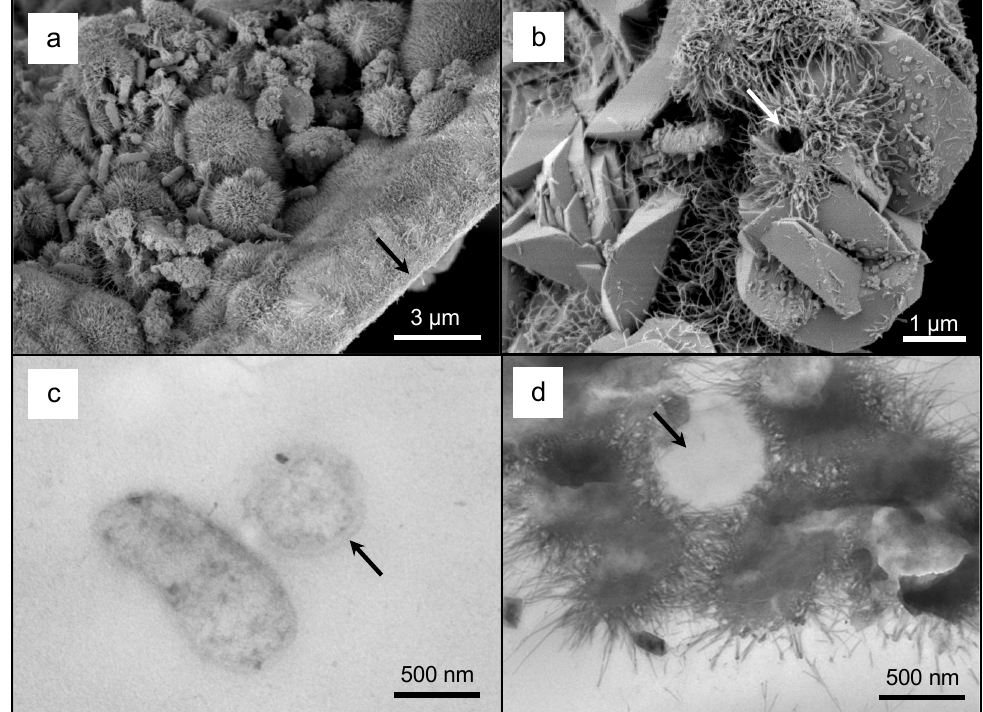
Figure 5. A low-magnification secondary electron (SE) scanning electron microscope (SEM) micrograph of the pseudoacicular schwertmannite with bacterial cells ( a ). The ‘flat’ edge ( a , arrow) is attributed to the inside surface of the borosilicate glass test tubes on which the iron oxyhydroxide mineral (IOM) precipitate had nucleated. A high-magnification SE SEM micrograph of the euhedral jarosite ( b ). Note the bacterial-size mold within schwertmannite ( b , arrow) and the bacterium to the left. A low-magnification transmission electron microscope (TEM) micrograph of two cells from the bacterial enrichment ( c ). Note the tangential section (left) and the cross-section (right) through the cells as well as preservation of the cell wall structure ( c , arrow). A low-magnification TEM micrograph confirming the structure of bacterial molds within schwertmannite ( d , arrow).